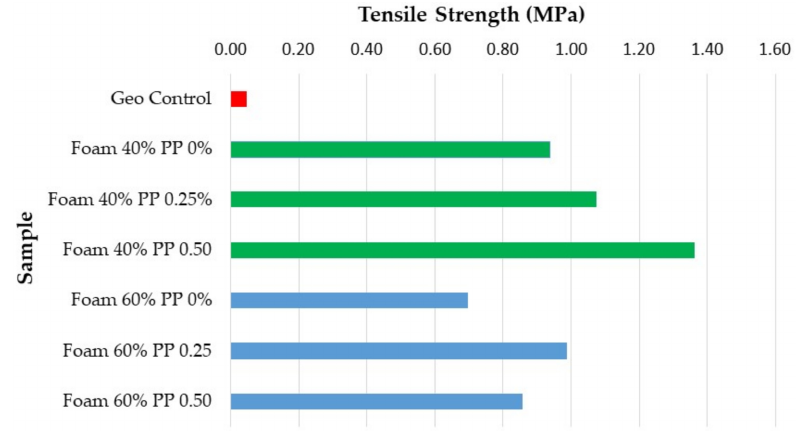
Figure 8. Tensile strength of foamed